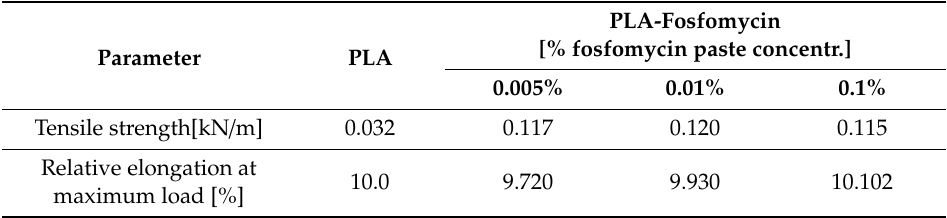
Table 6. Results of tensile strength test of modified polylactide (PLA) nonwovens.